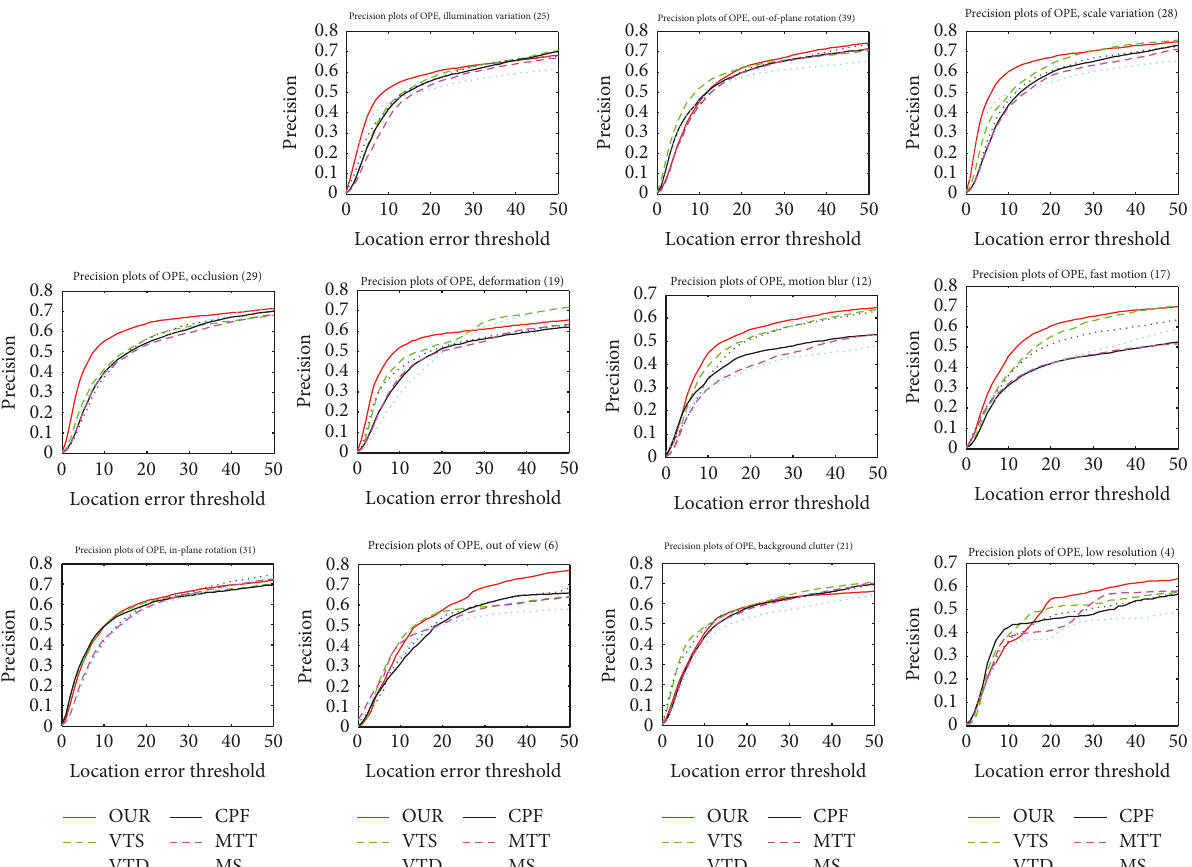
Figure 4: The precision plots of videos with multiple attributes.